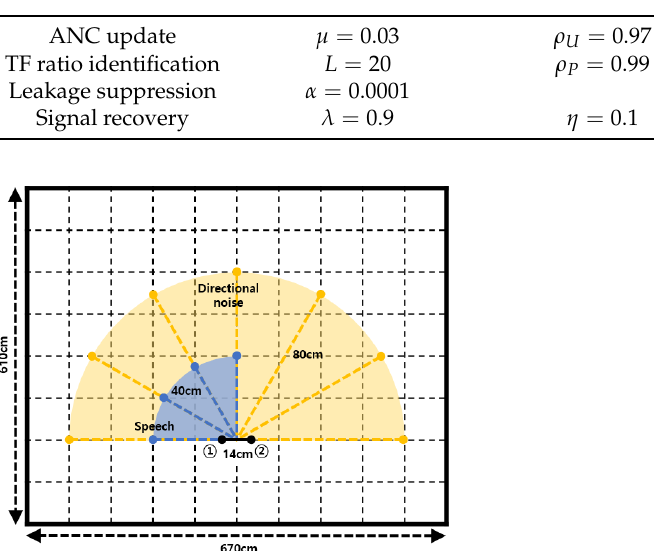
Table 1. Parameters used for the baseline and proposed beamformers.